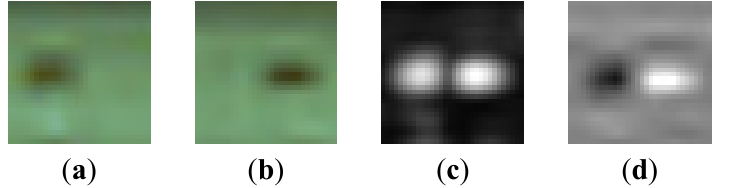
Figure 14. ERGAS-SNS analysis of a dark vehicle: ( a ) composite MS1 image; ( b ) composite MS2 image; ( c ) ERGAS result; ( d ) SNS